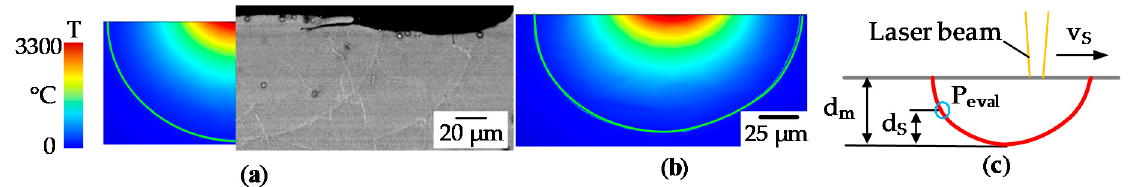
Figure 8. ( a ) Comparison of a cross-section for P L = 133 W, v s = 80 mm/s, Δ y = 60 µm, T pre = 0 °C from the simulation (melt pool boundary marked by green line) and experiment (SEM, EHT = 20 kV, WD = 8.6 mm, Mag = 750×, AsB-Detector) ( b ) longitudinal cross-section from simulation ( c ) Evaluation point P eval (blue circle) for the solidification conditions.